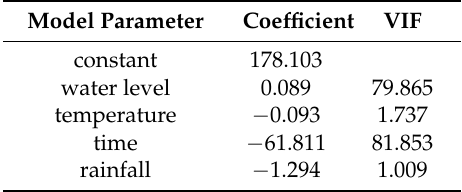
Table 2. The result of the analysis in the traditional research method.